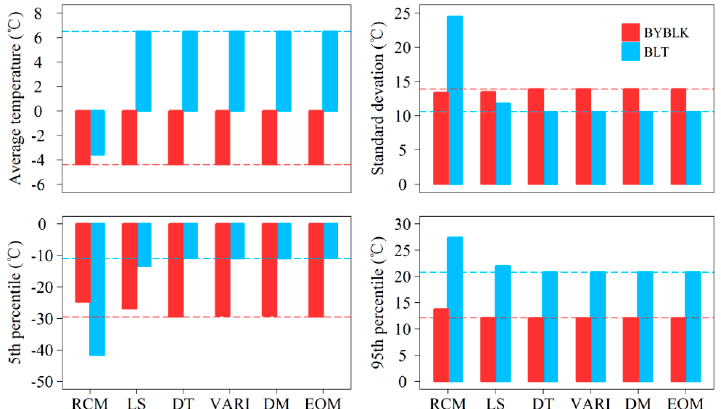
Figure 9. The average temperature, 5th percentile temperature, 95th percentile temperature, and standard deviation at BYBLK and BLT meteorological stations in the period 1965–2004.